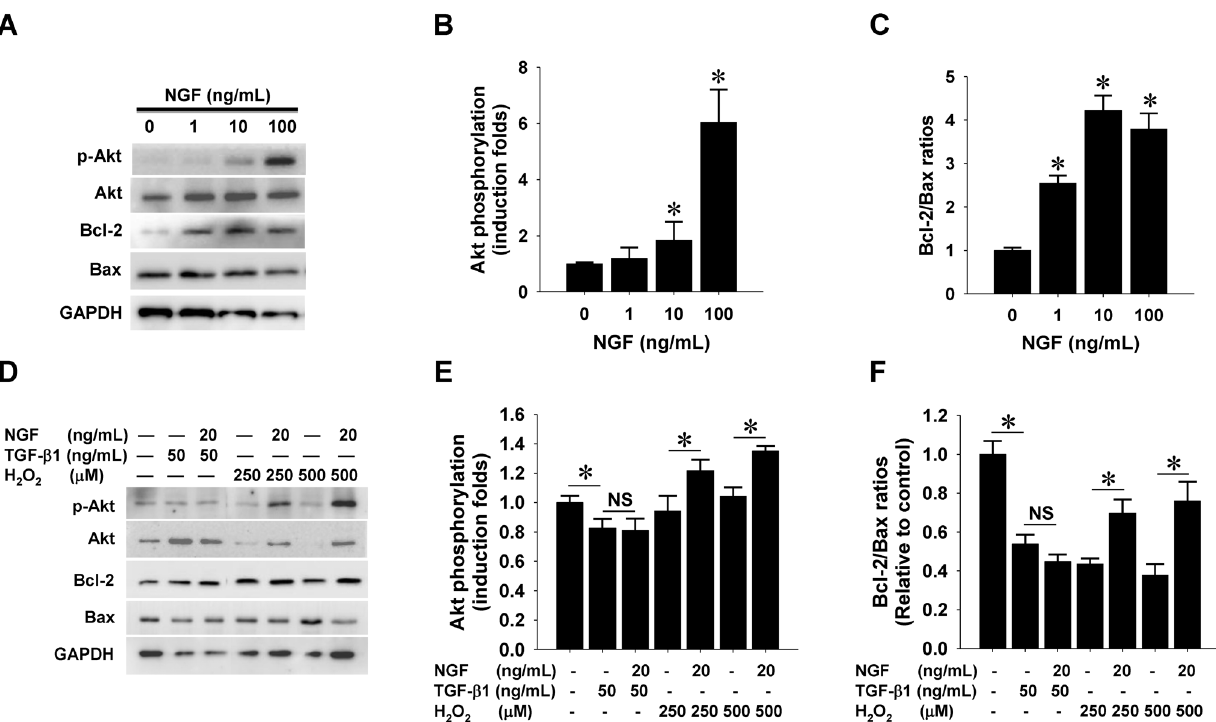
Figure 8. In vitro biomodulatory effect of NGF in cultured hepatocytes. (A) Clone-9 hepatocytes were treated with recombinant NGF for 24 hrs at indicated doses. Protein lysates were collected and subjected to Western blot detection for phosphor-Akt, total Akt, Bcl-2 and Bax expression levels. The relative Akt phosphorylation (B) and the ratios of Bcl-2 to Bax protein levels (C) were densitometrically measured. (D) Primary rat hepatocytes were exposed to TGF- b 1 with or without 24 hrs of NGF pretreatment and the lysates were subjected to Western blotting. Subsequent densitometry showed that NGF pretreatment significantly increased Akt phosphorylation in the cells with H 2 O 2 , but not TGF- b 1 insult (E). Similarly, NGF prominently ameliorated the down-regulated ratio of Bcl-2 and Bax proteins only in the cells with H 2 O 2 exposure (F). Data are representative results from three independent experiments and shown as mean 6 SD. * indicates P , 0.05 compared with negative control or between groups. NS, not significant.